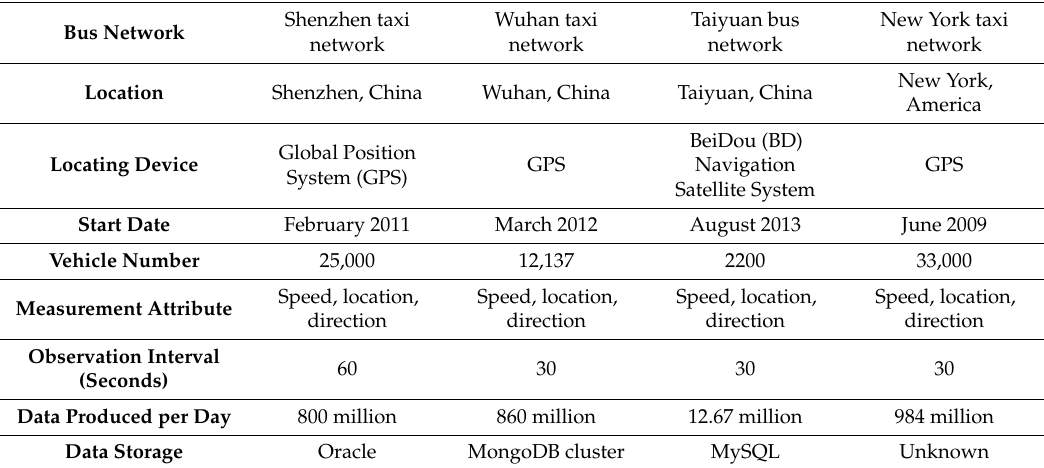
Table 1. Heterogeneous and typical vehicle monitoring